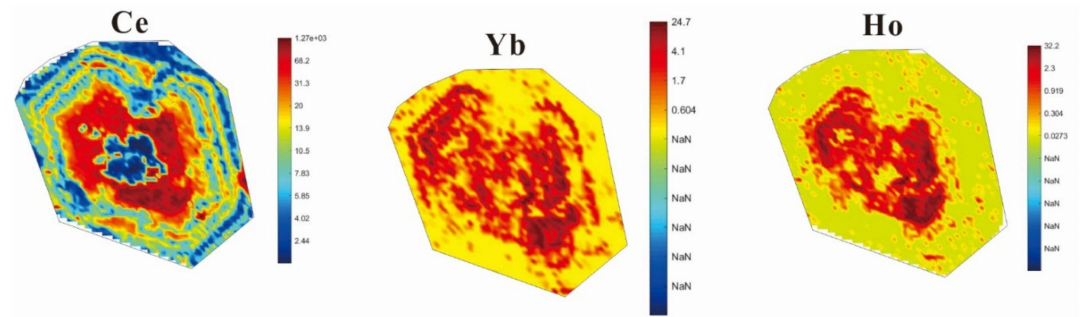
Figure 8. LA-ICPMS probability density maps illustrating element distribution within one garnet crystal with oscillatory-zoned anisotropic rim and isotropic cores, and a calcite inclusion is identified (with very low Si content) and excluded for